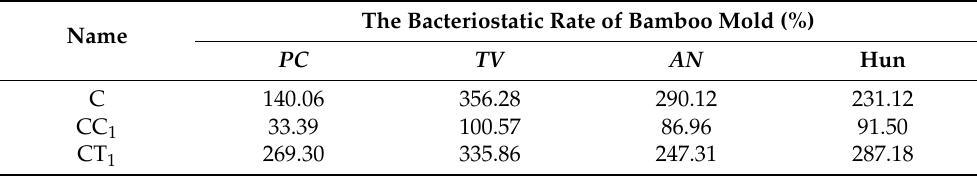
Figure 4. Effects of citral and citral compound solutions on the diameters of the inhibition zone of bamboo molds (C, citral solution; CC 1 , a compound formulated with citral and cinnamaldehyde; CT 1 , a compound formulated with citral and thymol). Table 3. Effects of citral and citral compound solutions on the inhibition rates of bamboo mold.